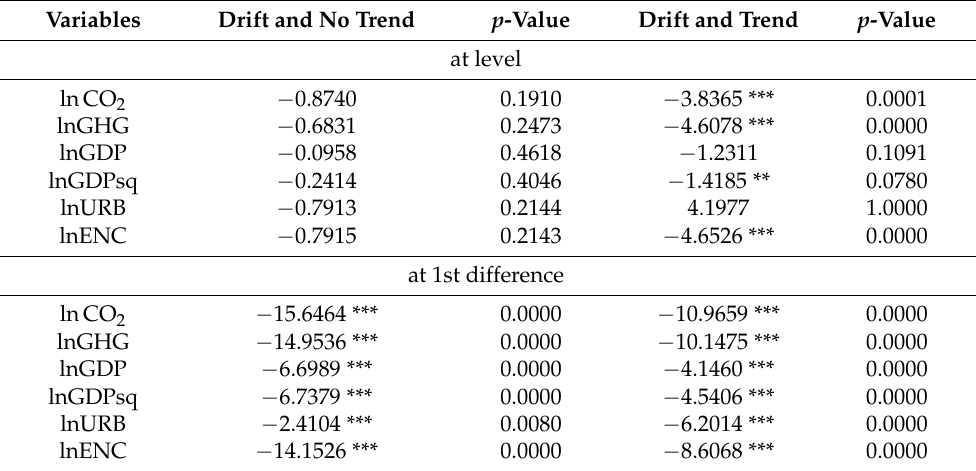
Table 4. Im–Pesaran–Shin Panel unit root test (W-t-bar statistics).